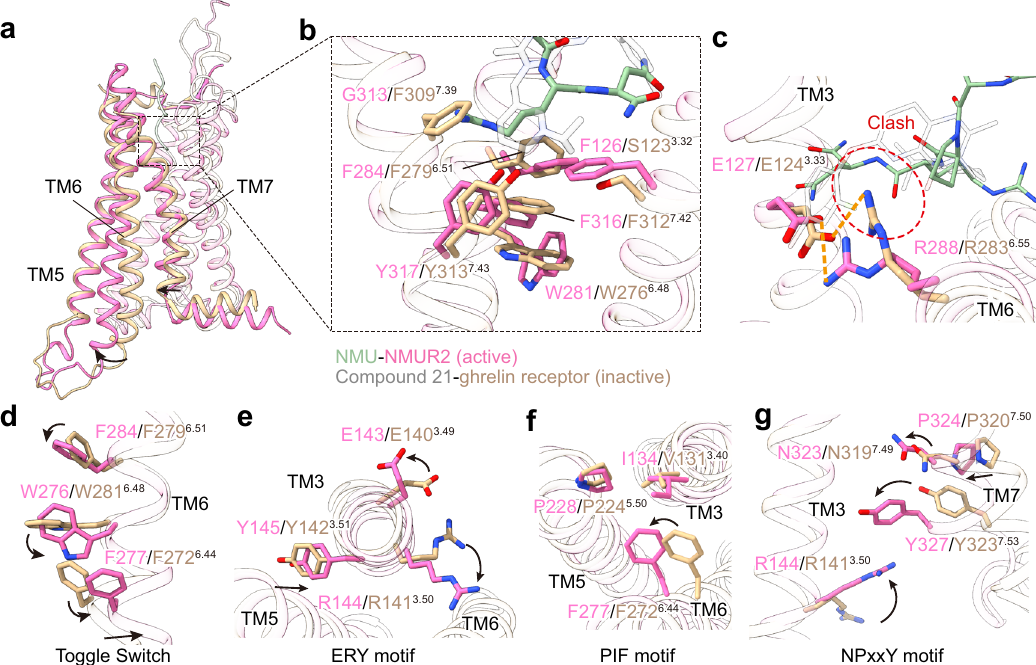
Fig. 4 Activation mechanism of NMURs. a Structural superposition of active NMUR2 and antagonist-bound ghrelin receptor (PDB 6KO5) from the side view. The movement directions of TMs in NMUR2 relative to the ghrelin receptor are highlighted as black arrows. NMUR2 and ghrelin receptor are colored in hot pink and wheat, respectively. b Interactions between NMU and residues located at the bottom of peptide binding pocket. c Comparison of interaction between peptide and R 6.55 . The possible clash is highlighted by a red dashed circle. Hydrogen bonds and salt bridges are depicted as orange dashed lines. Compound 21, the antagonist of ghrelin receptor, and NMU are colored in grey and green, respectively. d – g Conformational changes of the conserved “ micro-switches ” upon receptor activation, including Toggle switch ( d ), ERY ( e ), PIF ( f ), and NPxxY ( g ) motifs. The conformational changes of residue side chains are shown as black arrows upon NMUR2 activation in contrast to the antagonist-bound ghrelin to directly contact the “ toggle switch ” residue W281 6.48 , which often undergoes a movement upon ligand binding 45,46 (Fig. 4b).